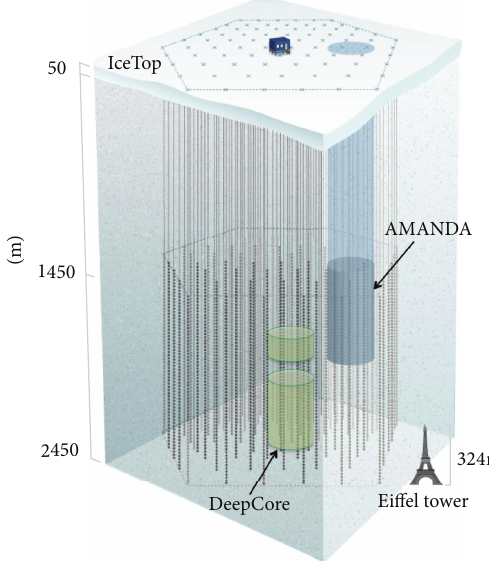
Figure 7: The IceCube detector, consisting of IceCube and IceTop and the low-energy sub-detector DeepCore. Also shown is the first- generation AMANDA detector.